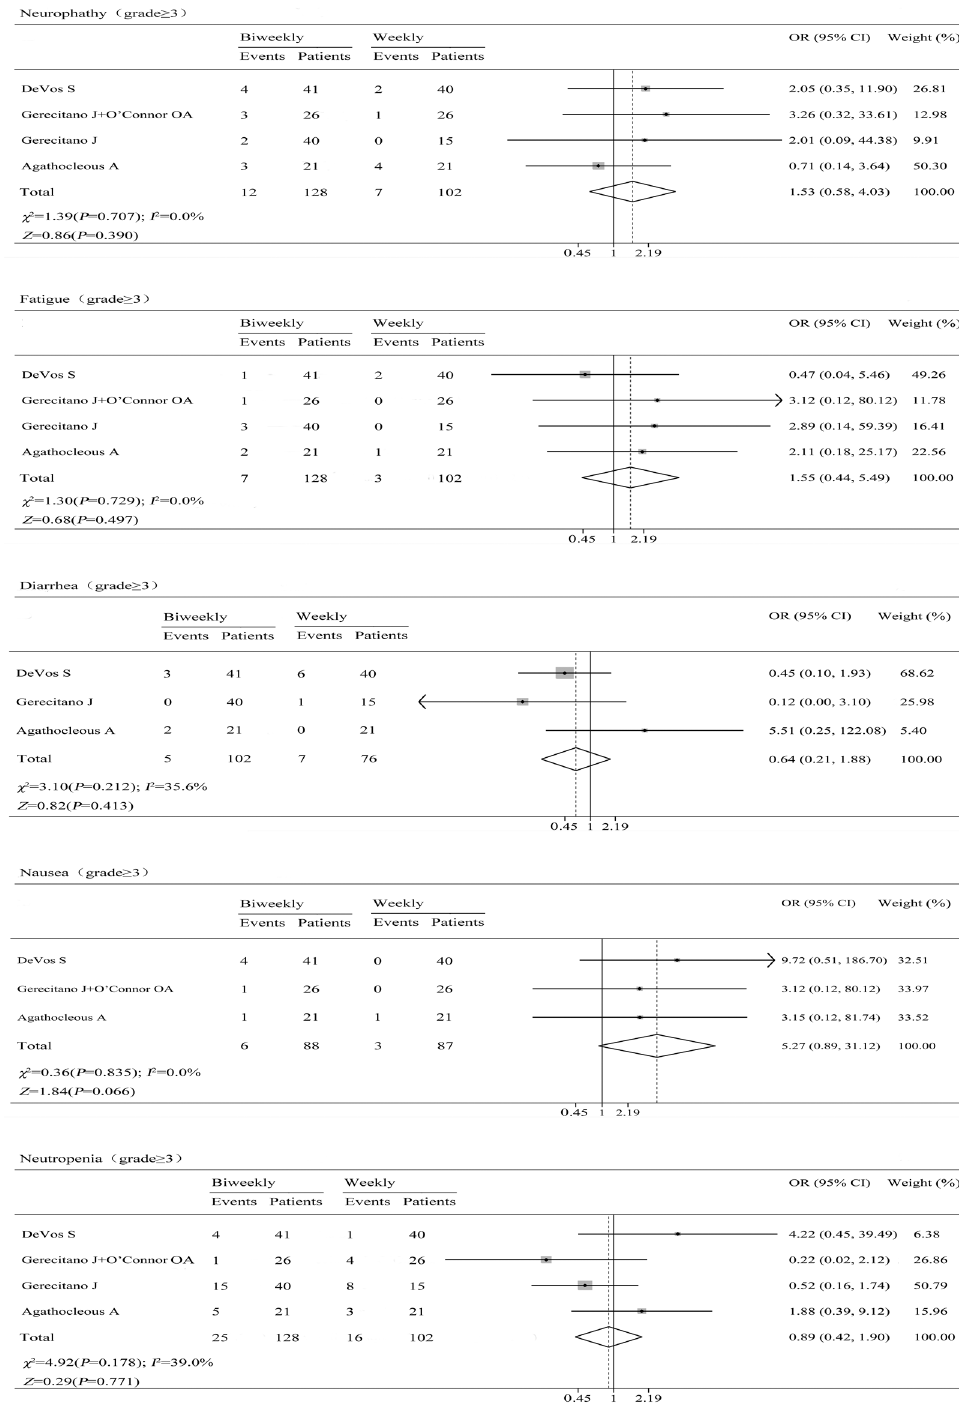
Fig 4. Pooled analyses of neuropathy, fatigue, diarrhea, nausea, and neutropenia (grade (cid:21) 3).